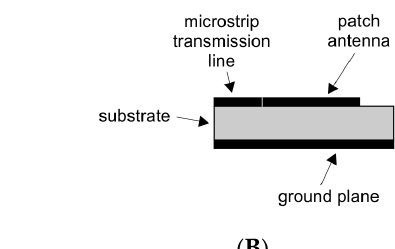
Figure 3 . The mask used to develop the microstrip patch antenna on the circuit board. ( A ) Top view of the patch antenna and ( B ) side view of the microstrip antenna.